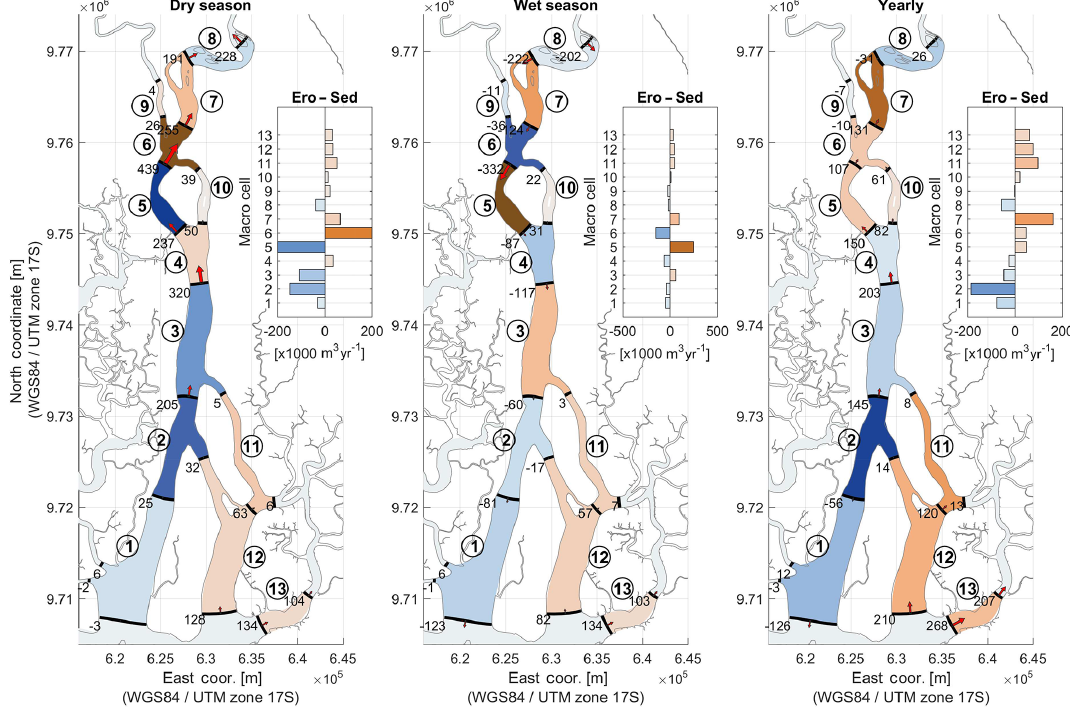
Figure 11. Sediment balance computed yearly and seasonally for deforestation and land use change in the upper basin (Case 3).